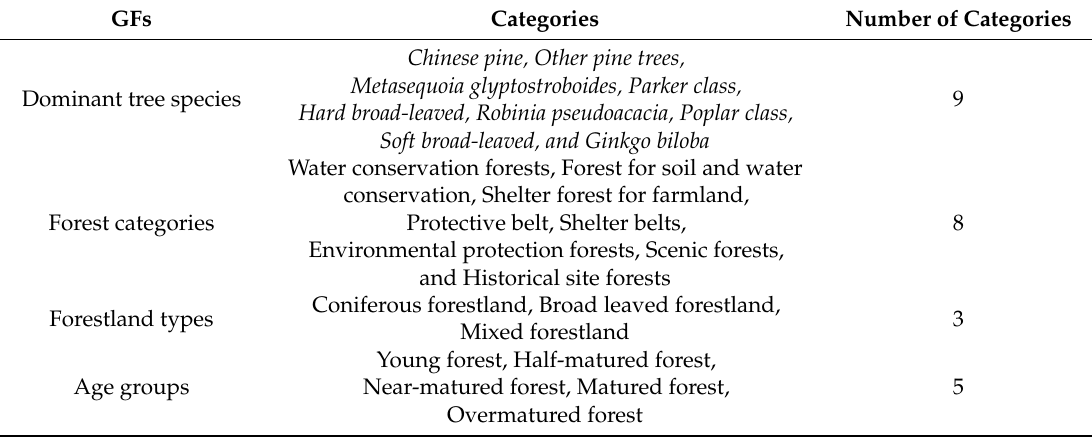
Table 2. Four geographical factors (GFs) and their